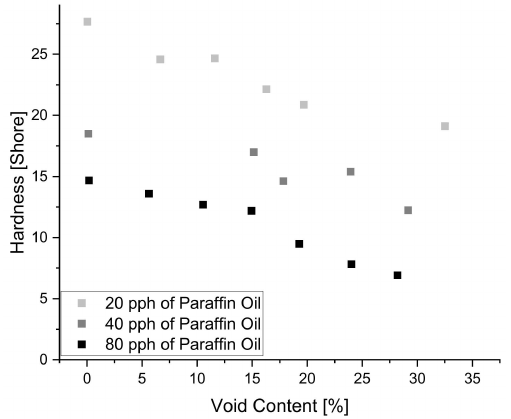
Figure 26. The influence of paraffin oil content on